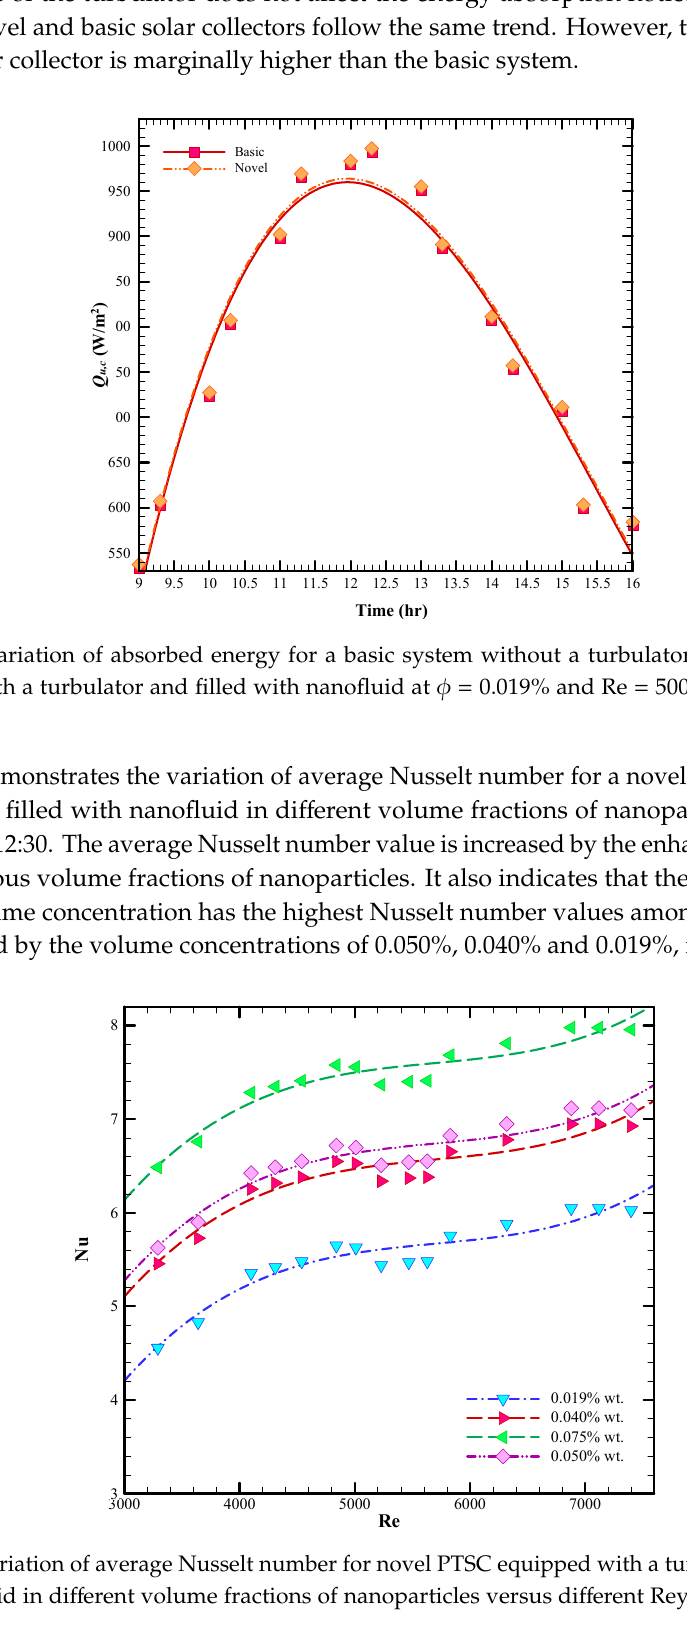
Figure 11. Variation of exergy efficiency for a basic system without a turbulator and novel PTSC equipped with a turbulator and filled with nanofluid at ϕ = 0.019% and Re = 5000 versus different times of day.